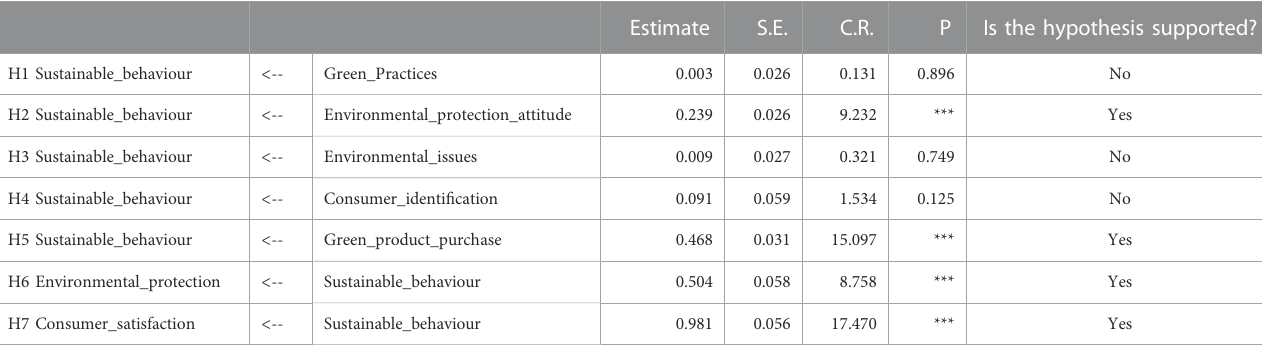
TABLE 7 Summary of the structural model analysis